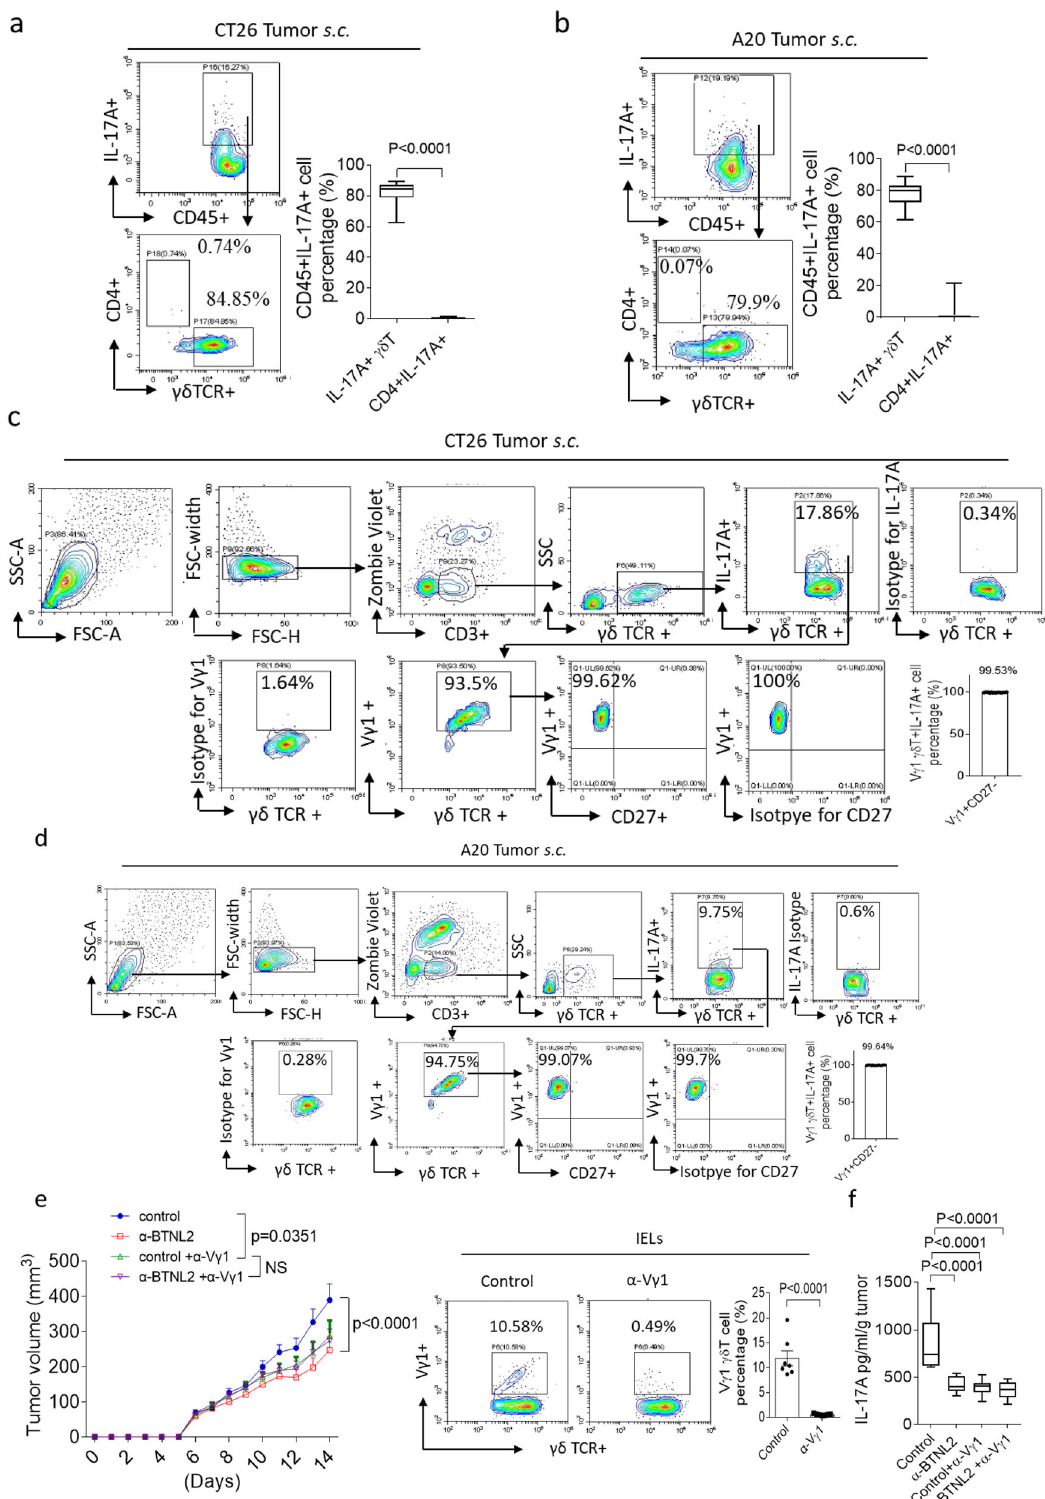
signi fi cantly inhibited the proliferation of CD8 + T cells and OVA peptide-stimulated OT-1 CD8 + T cells in the in vitro system (Supplementary Fig. 5d, e). Consistent with this, IL-17A neutraliza- tion also led to decreased MDSC and increased CD8 + IFN- γ + T cells in fi ltration in the TME (Fig. 4k). Treatment with recombinant IL- 17A-Fc protein abolished the BTNL2 blockade-mediated